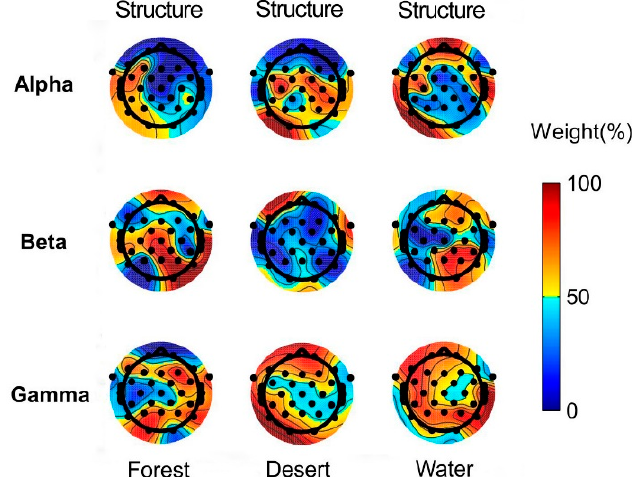
Figure 6. The weights of structure and color in landscape image recognition for different landscape types using alpha, beta, and gamma waves. Predominantly orange electrodes represent the dominance of structure, whereas predominantly blue electrodes represent the dominance of color in different landscapes.